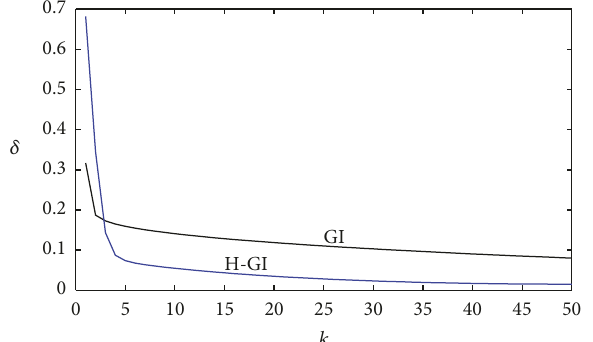
Figure 2: The GI and H-GI estimation errors 𝛿 versus 𝑘